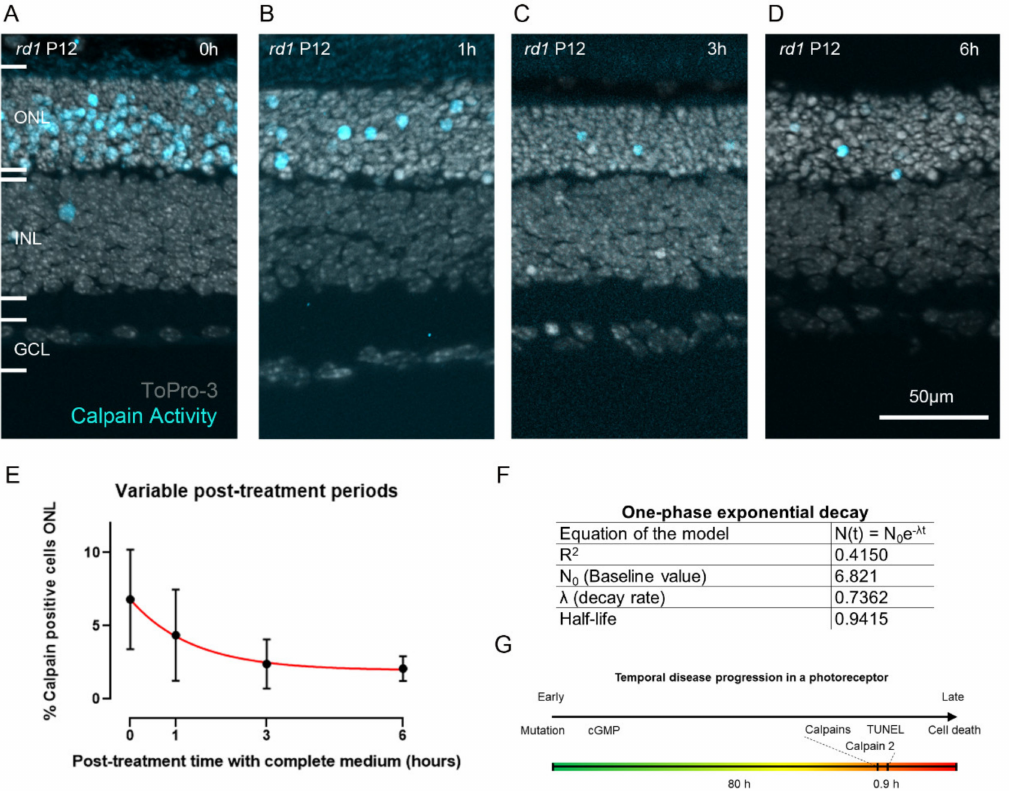
Figure 5. Estimation of the duration of calpain activity during photoreceptor cell death. ( A – D ) Organotypic retinal explant cultures derived from the rd1 mouse model were treated with the CMAC substrate for 6 h. The medium containing CMAC was then replaced by plain, unlabeled medium for varying durations: 0 h ( A ), 1 h ( B ), 3 h ( C ), or 6 h ( D ). ( E ) Quantification of calpain- positive cells in the outer nuclear layer (ONL). The number of detected calpain-positive cells over time followed an exponential decay. Red line shows model fit. ( F ) Table showing model equation and parameters. ( G ) Putative timeline for disease progression in an individual photoreceptor cell. Error bars indicate STD. INL = inner nuclear layer, GCL = ganglion cell layer. Images representative of results obtained from six to nine independent retinal explant cultures per